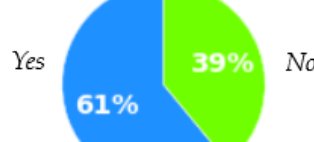
Figure 16. Answers for question of do you think that the legal trade of cryptocurrencies should be firstly permitted to operate and test in China’s Xiamen pilot FTZs?